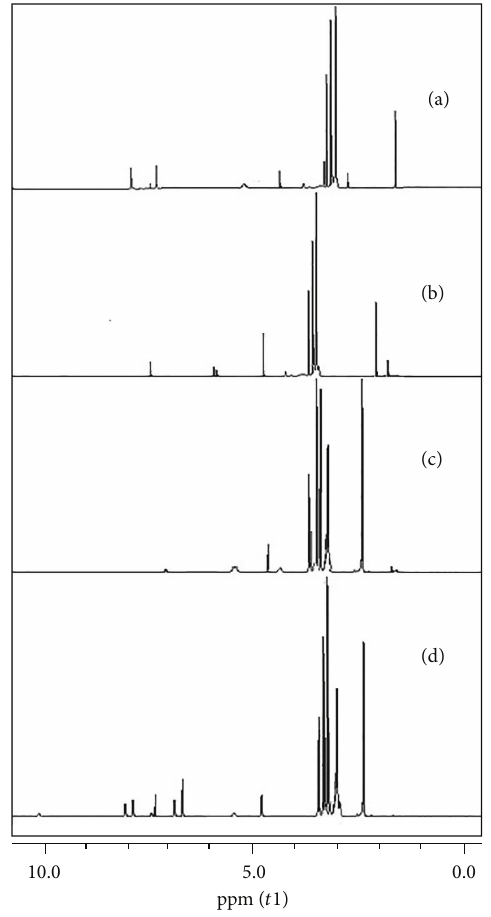
Figure 2: 1 H NMR spectra of PEG-diOTs (a) in CDCl 3 , PEG-diThy , and PPR-Fl (d) in DMSO- (b) in CDCl 3 , PPR (c) in DMSO- d 6 d 6